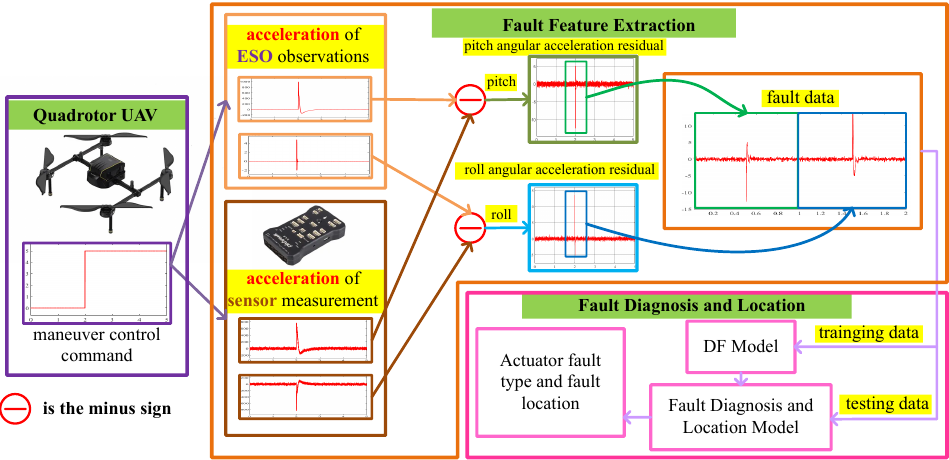
Figure 3. The overall framework of fault diagnosis and localization of the quadrotor UAV actuator based on